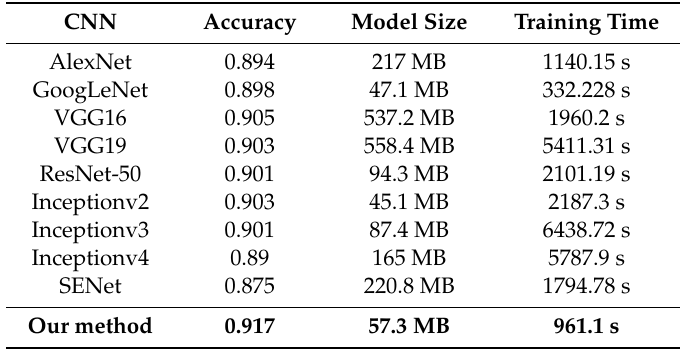
Table 3. Classification accuracy (in percent) comparison of CNN-Based models.